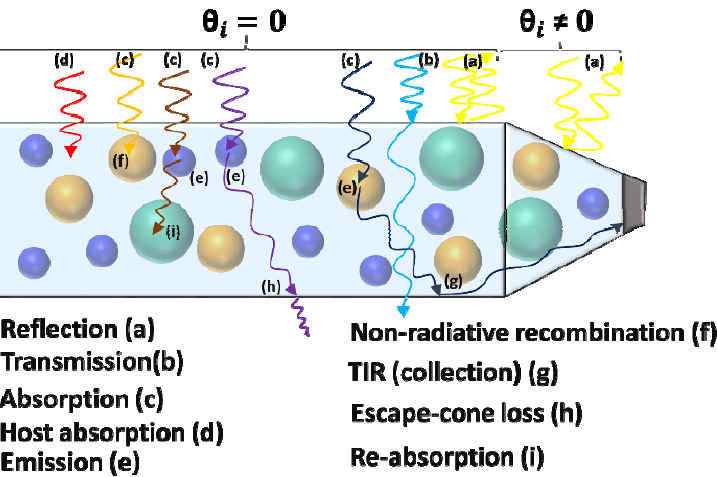
Figure 3. Side view of the antenna and different possible events that may take place inside the antenna when the light is irradiated to the upper surface of the antenna.